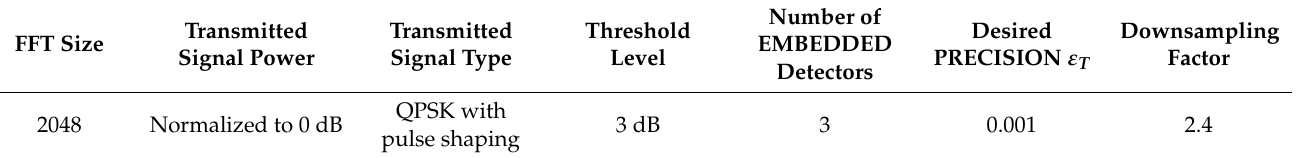
Table 1. Parameters used for the simulation